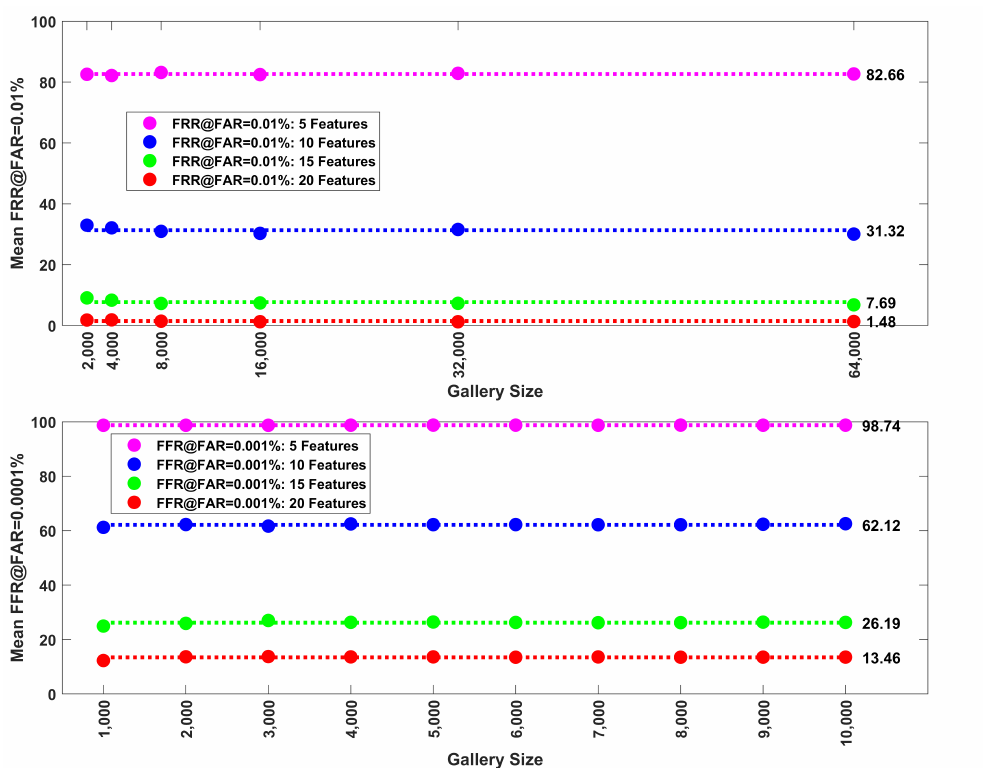
Figure 8. ( Top ): In addition to mean EER, we also evaluated the mean false rejection rate (FRR) at a false positive rate of 0.01%. Here we plot these error rates (mean of 30 repetitions) versus gallery size (1000, 2000, 4000, 8000, 16,000, 32,000, 64,000 subjects) for synthetic data (Band 8). Data shown for 5, 10, 15 and 20 features. The average error rates (shown to the right of the last dot) across gallery size are illustrated with dotted lines. There was some instability at small gallery sizes, but otherwise, the mean error rate did not change as a function of gallery size. ( Bottom ): FRR at FAR = 0.0001%. Here we plot these error rates (mean of 30 repetitions) versus gallery size (1000 to 10,000 in steps of 1000 subjects) for FaceNet PCA components. Data shown for 5, 10, 15 and 20 PCA components. The average error rates (shown to the right of the last dot) across gallery size are illustrated with dotted lines. The mean error rate did not change as a function of gallery